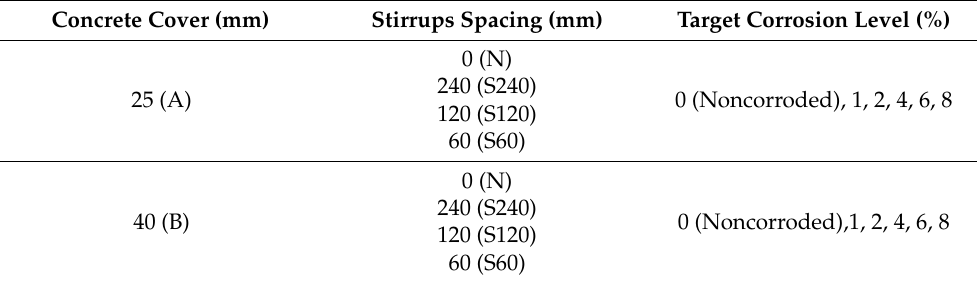
Table 2. Test matrix of the specimens.